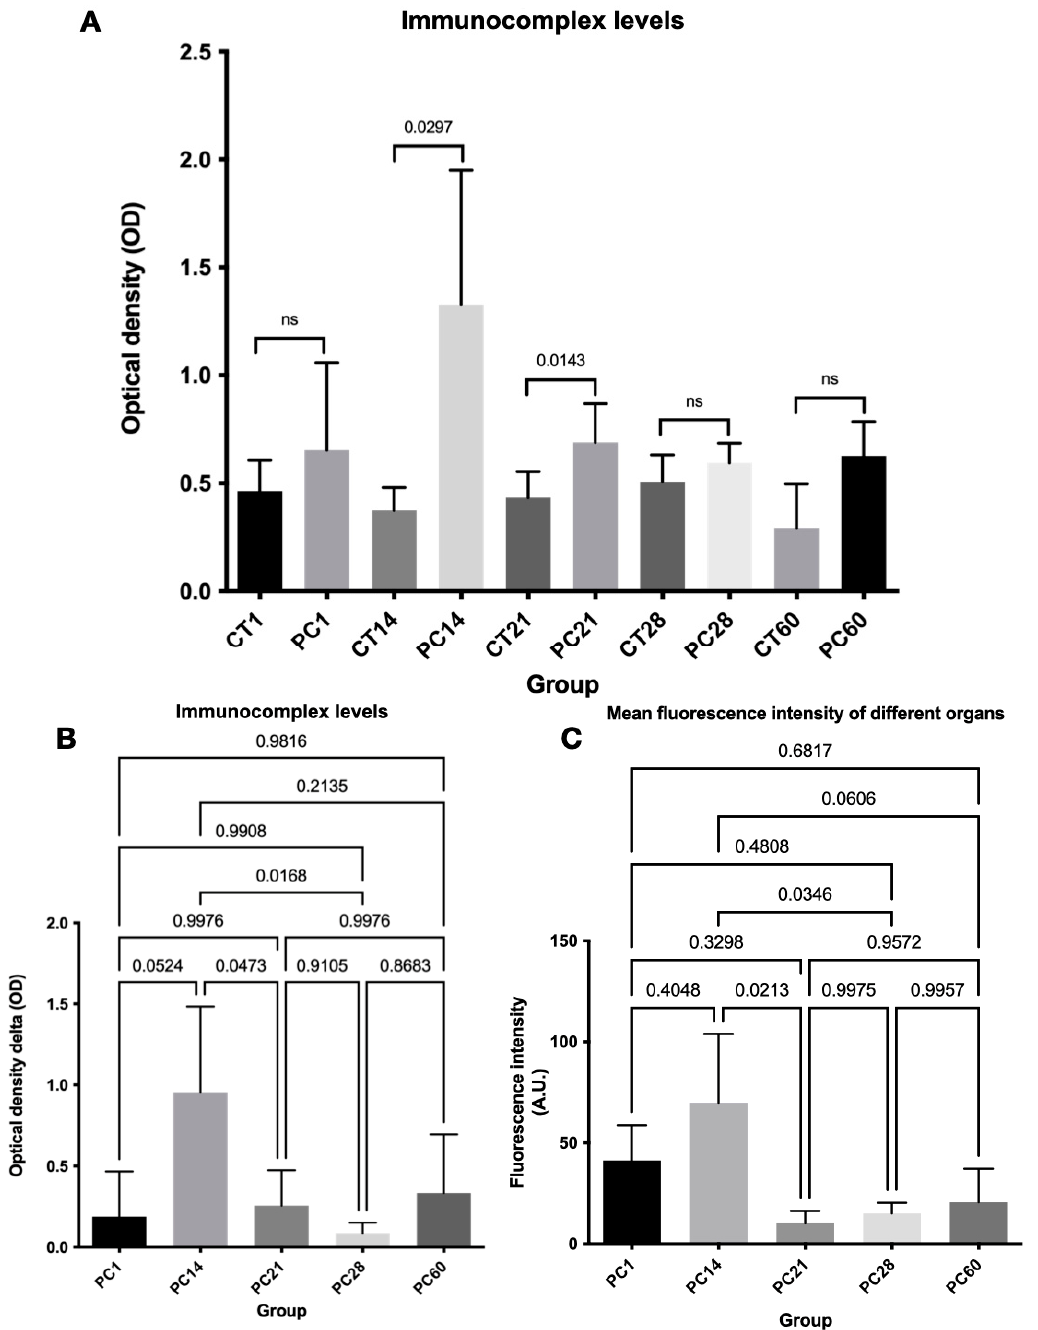
Figure 4. Immunocomplex serum levels were measured by precipitation and ELISA. ( A ) Higher levels of ICs were found in the mice that received the cell wall preparation of Mtb H37Rv, but not in the controls. ( B ) The levels of ICs measured in the control group were subtracted from the experimental group to better track this phenomenon, revealing that the highest relative level of ICs occurred on day 14. ( C ) Mean fluorescence intensity of brain (MFI), lungs, and kidneys. Each tissue microphotograph showed a correlation between the quantitative MFI values and the semiquantitative image interpretations. A high level of MFI was observed on day 14. Abbreviation: CT 1, 14, 21. 28, 60: control of day 1, 14, 21, 28, 60, respectively. ns; no significant difference. PC 1, 14, 21, 28, 60: group that received the cell wall preparation of Mtb H37Rv of day 1, 14, 21, 28, 60, respectively.